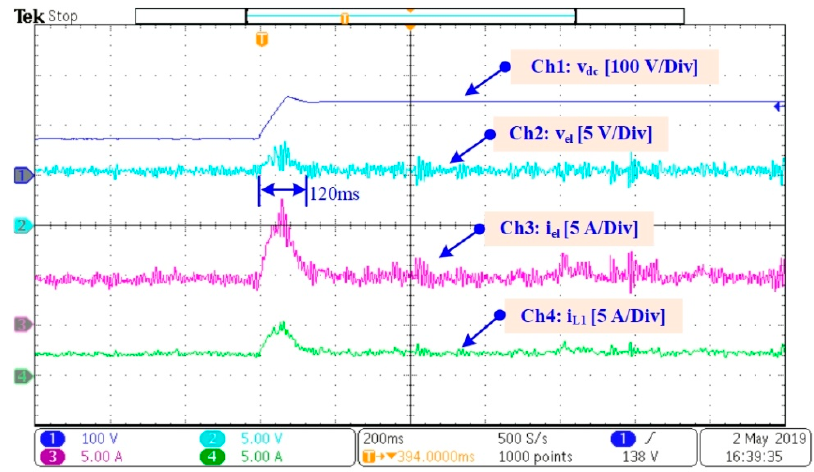
Figure 9. test from V dc = 75 V to V dc = 150 V: channel 1: DC bus voltage (V dc ), channel 2: PEM EL voltage (V el ), channel 3: PEM EL current (I el ), channel 4: first phase current (I L1 ).